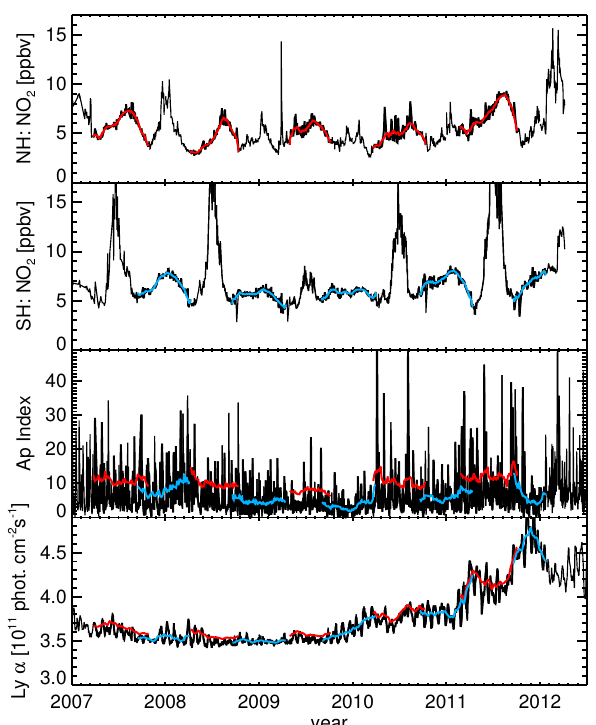
Table 1. Time periods for which MIPAS NO 2 data are used in the